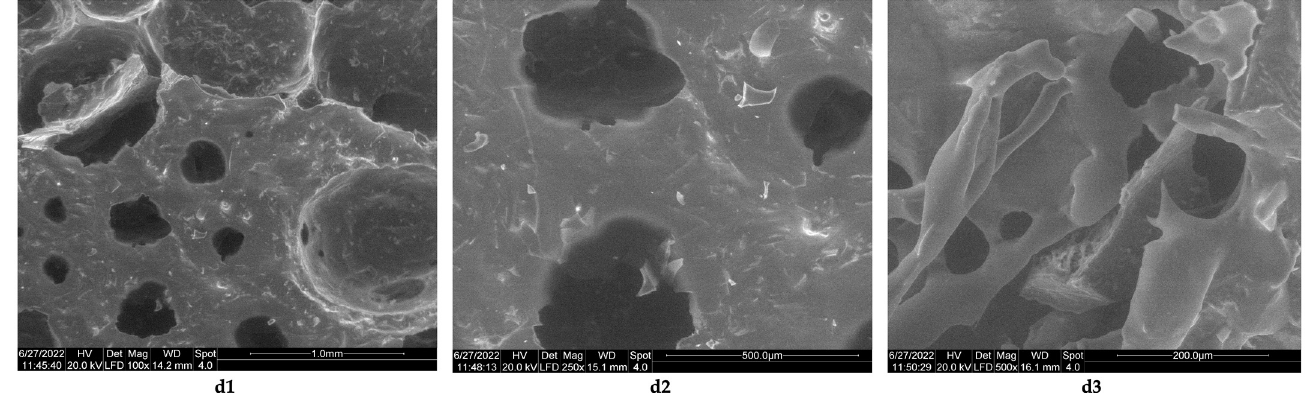
Figure 8. Morphology of composite biomaterial between collagen and chitosan obtained at a collagen–chitosan mass ratio of 3:1. ( d1 ) porous structure of sponge with pores diameters under 1 mm (magnification 100×); ( d2 ) pores geometry from the sponge with diameters under 500 μ m (magnification 250×); ( d3 ) small pores with dimension under 200 μ m microns (magnification 500×).